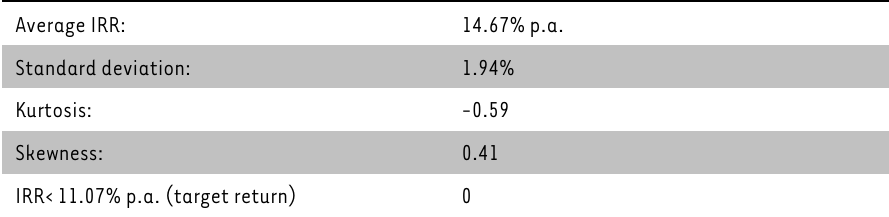
TABLE 10: Volatility of the IRRs of the investments of Set D Average IRR: 14.67% p.a. Standard deviation: 1.94% Kurtosis: -0.59 Skewness: 0.41 IRR< 11.07% p.a. (target return)